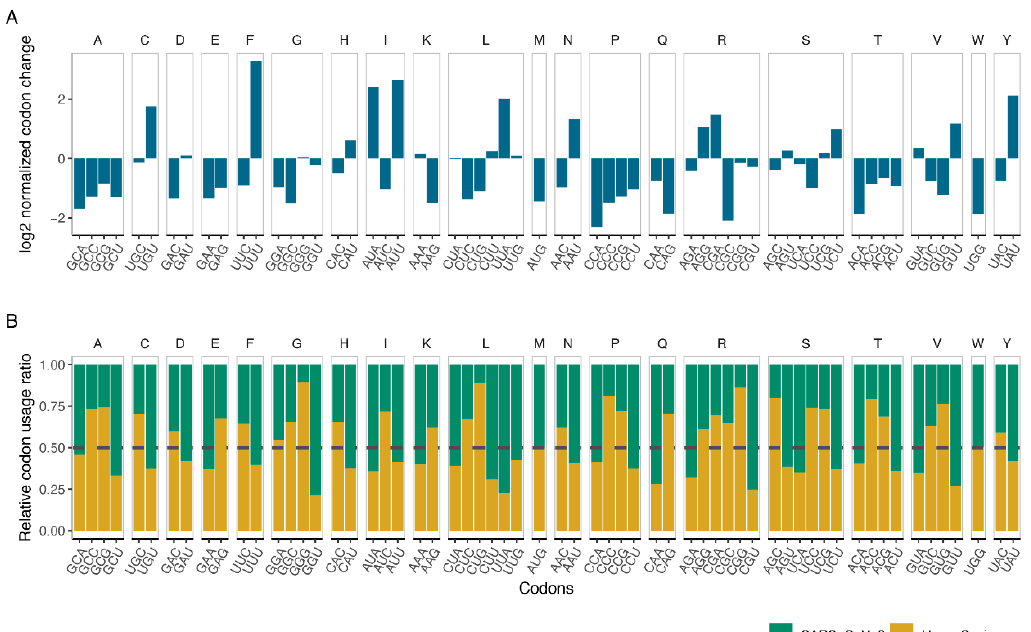
Figure 3. Comparison of codon variations in SARS-CoV-2 phylogenetic tree, human genome, and SARS-CoV-2reference genome. ( A ) Codon variations from mutations in the phylogenetic tree, represented by the ratio of formations over deformations per codon in log2 formation. ( B ) Relative codon usage percentage between Human and SARS-CoV-2 reference genome.